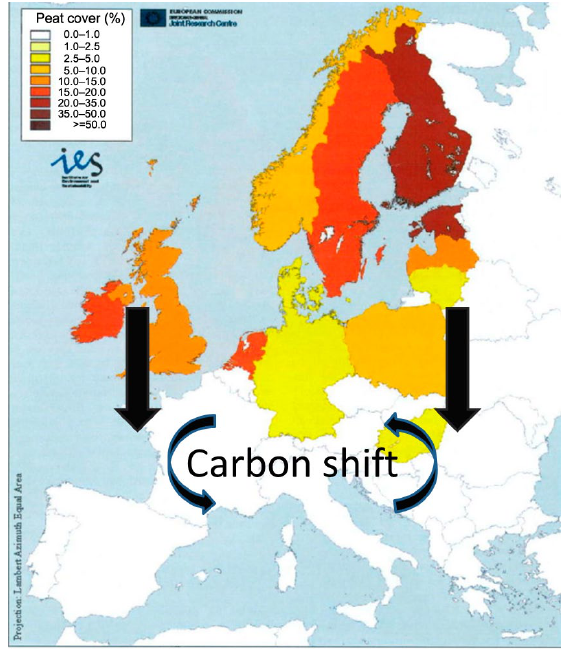
Fig. 1. Relative cover (%) of peat and peat-topped soils (0–30 cm) across Europe according to Montanarella et al . (2006). Currently there is a shift of peat from North Europe to Central and South Europe with C loss by